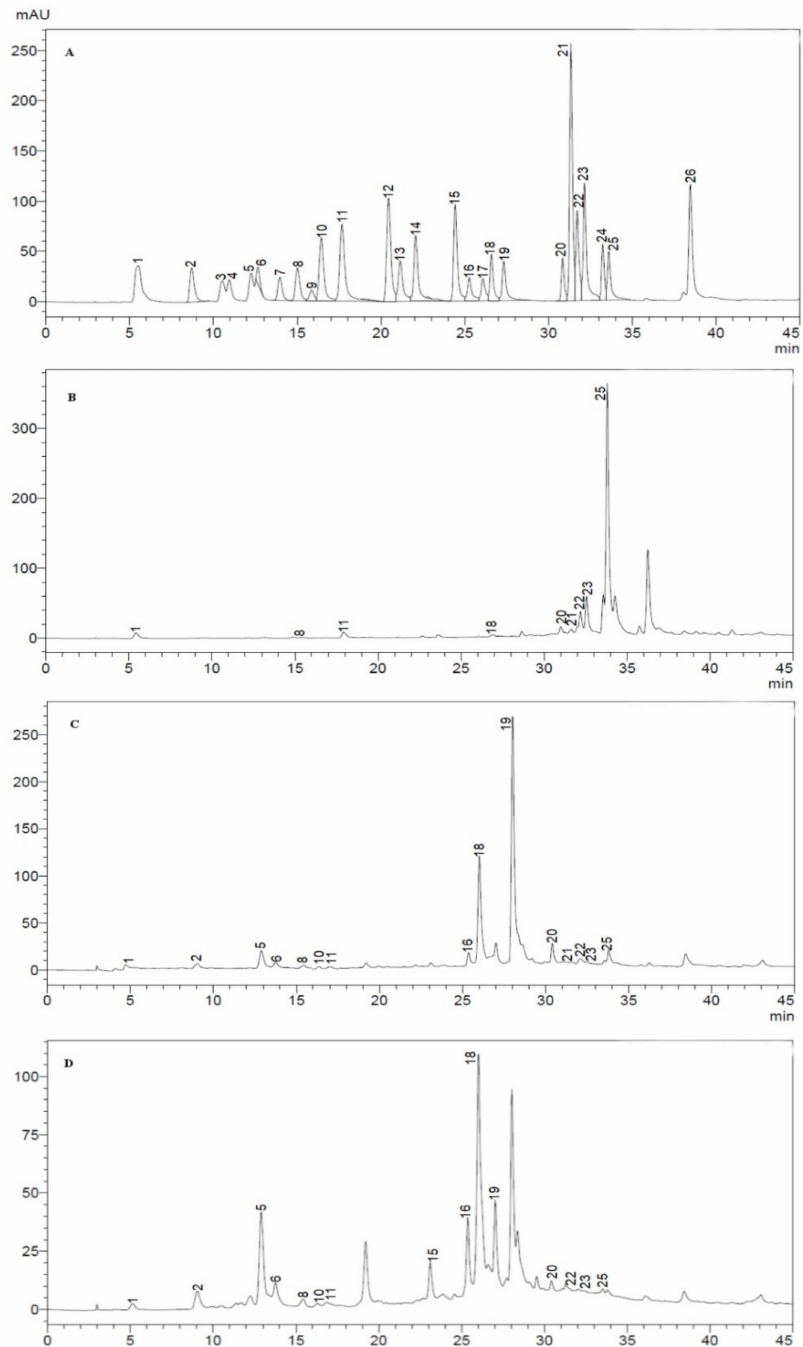
Figure 1. HPLC chromatograms of phenolic compounds; ( A ): Standards, ( B ): DCM extract of C. nepeta , ( C ): AcOEt extract of C. nepeta , ( D ): BuOH extract of C.